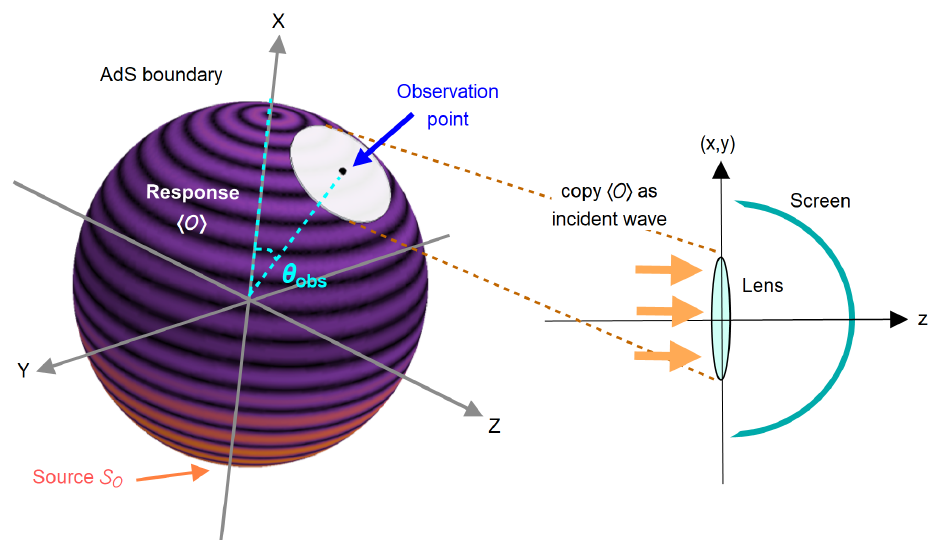
Figure 2 . Schematic diagram of a setup. We will project the response function onto the lens in the virtual optical system and build its image on the hemispherical